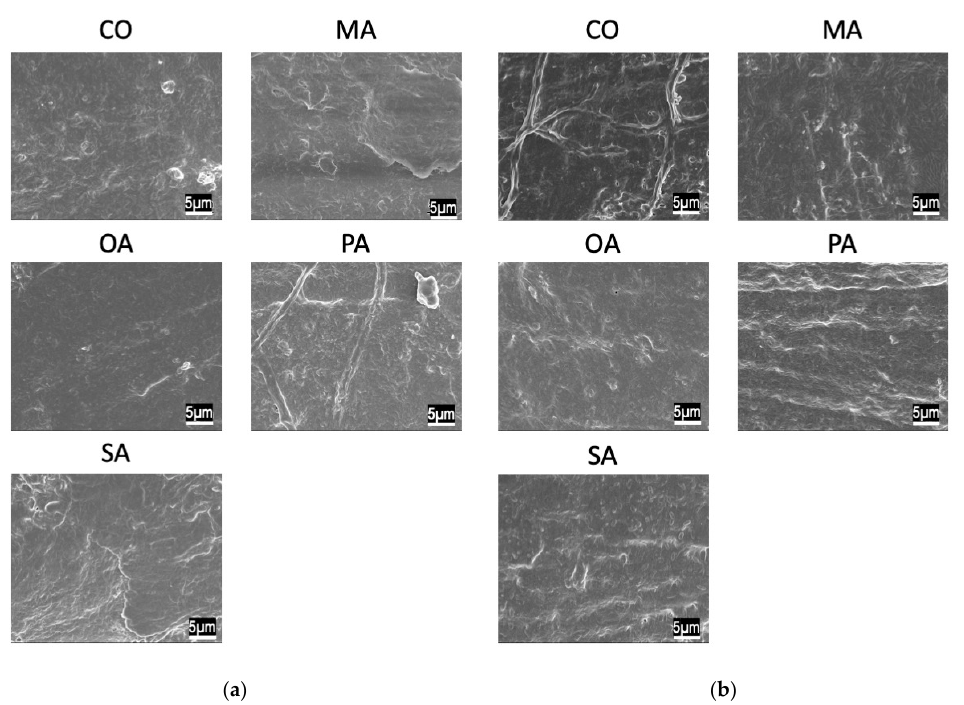
Figure 5. SEM images of each group after pH-cycling. ( a ) Deionized distilled water wash, ( b ) remineralization solution wash ( × 3000).